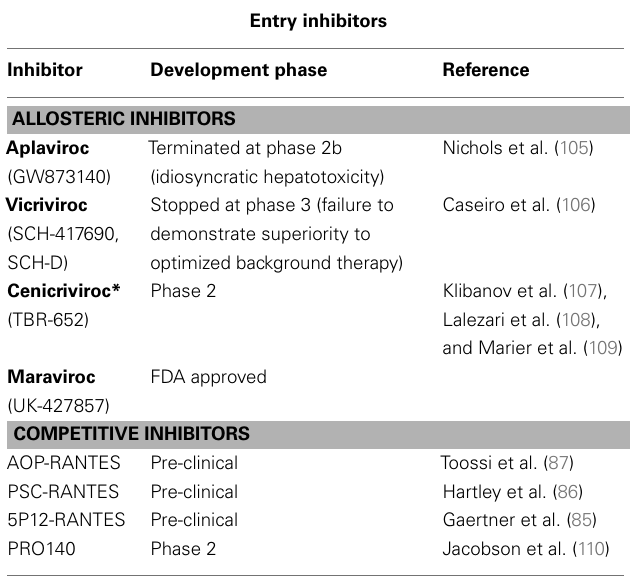
Table 1 | CCR5-directed therapies. Table 2 | CCR5 gene therapy